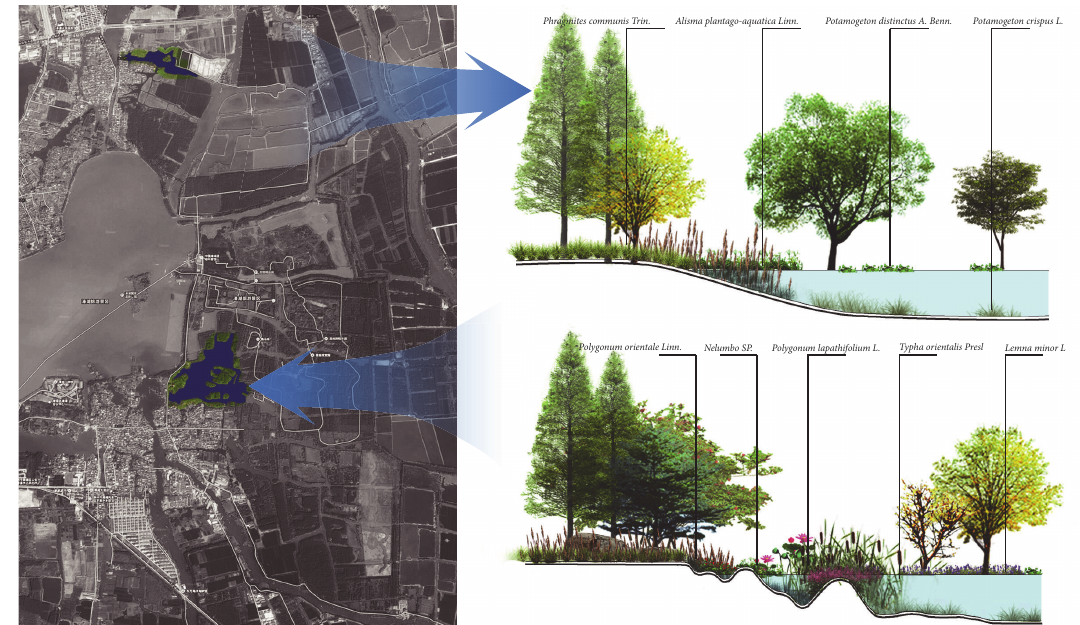
Figure 7: The structural comparison of revetments cross